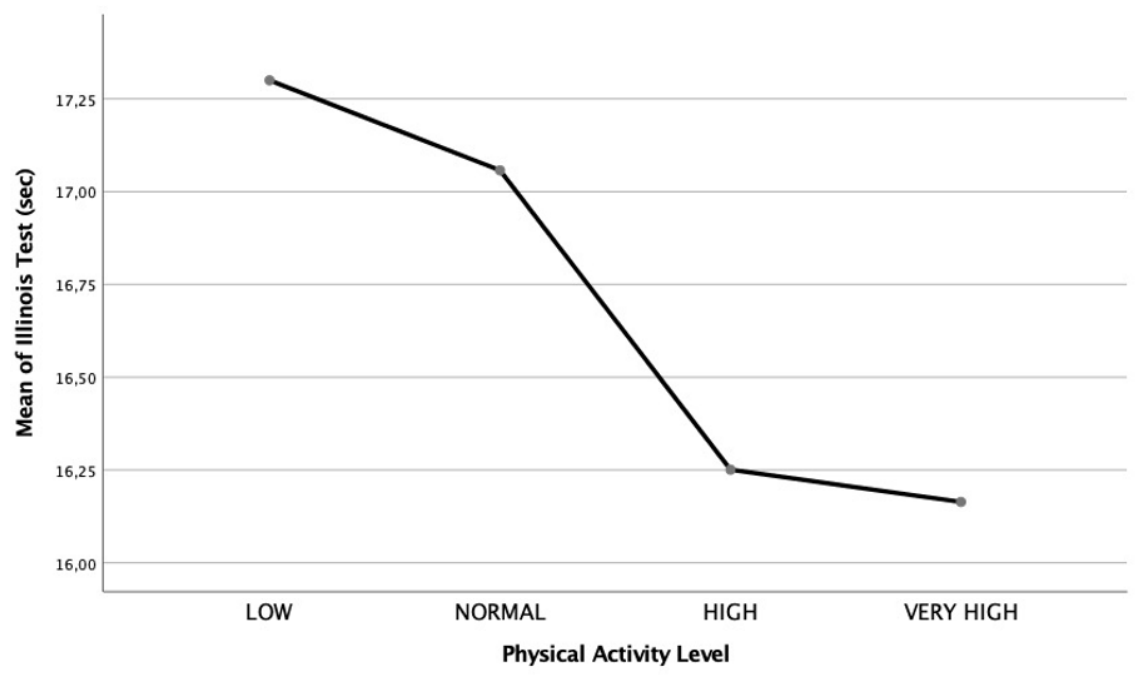
Figure 2. Average Illinois Agility Test (sec) according to the answers given by the participants to the physical activity question.